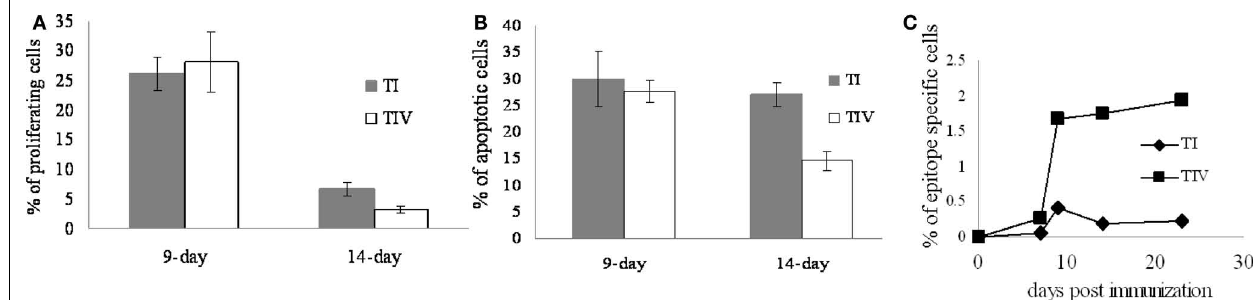
FIGURE 5 | Site I- and site IV-specificT CD8 s have different apoptosis kinetics after immunization. (A) Percentage of proliferating cells assessed by BrdU proliferation assay and (B) AnnexinV positive cells indicating apoptotic cells among site I (filled) and site IV (empty) specific T CD8 s.The site I-specificT CD8 s undergoing apoptosis are significantly higher